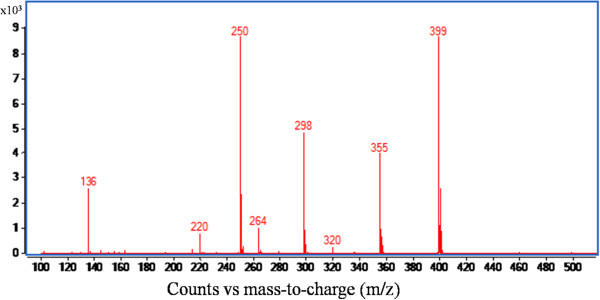
ESI mass spectrum corresponds to tR at 2.7 min.